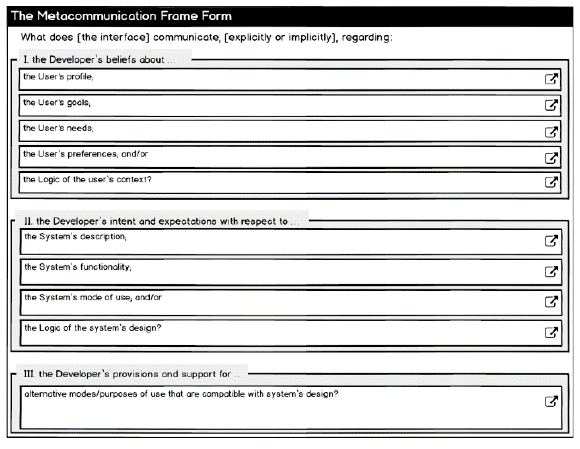
Fig. 4. . Metacommunication Frame Form – SigniFYIng Message frame